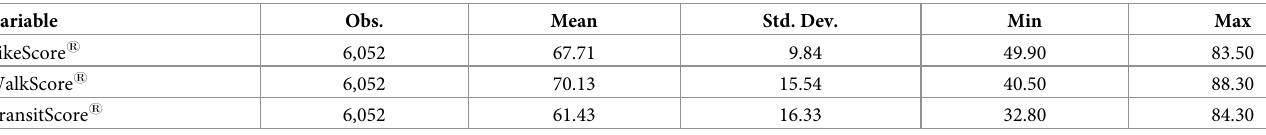
measures range from 0 to 100 and divide cities into different groups [1]. Based on the classifi- cation of BikeScore 1 , WalkScore 1 , and TransitScore 1 , the cities in our dataset scored less scores are given in Tables 7 and 8, respectively. Table 8. Descriptive statistics: BikeScore 1 , WalkScore 1 , and TransitScore 1 . Variable Obs. Mean Std.